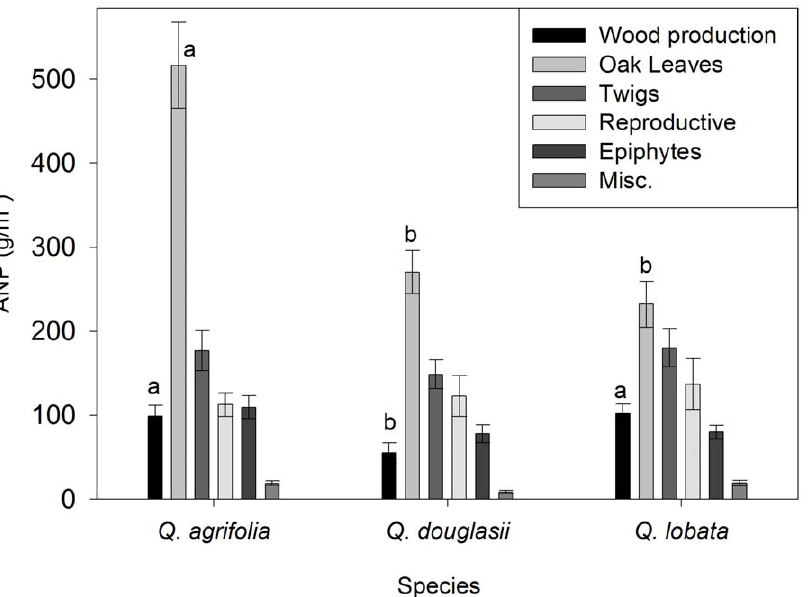
Figure 1. Five-year average ( ± SE) ANP of Quercusagrifolia (n=13), Q.douglasii (n=13 and Q.lobata (n=14). Reproductive litterfall consisted of acorns, acorn caps, aborted acorns (including unfertilized flowers) and catkins. Epiphytes included lichens, mosses and mistletoe. Miscellaneous includes insects, insect frass, and unidentifiable organic material. Significant differences among species include oak leaves (one-way ANOVA, F 2,37 =18.1, P , 0.001) and woody increment ( F 2,37 =5.5, P , 0.01). Different letters denote P , 0.05 in a Tukey post-hoc comparison among